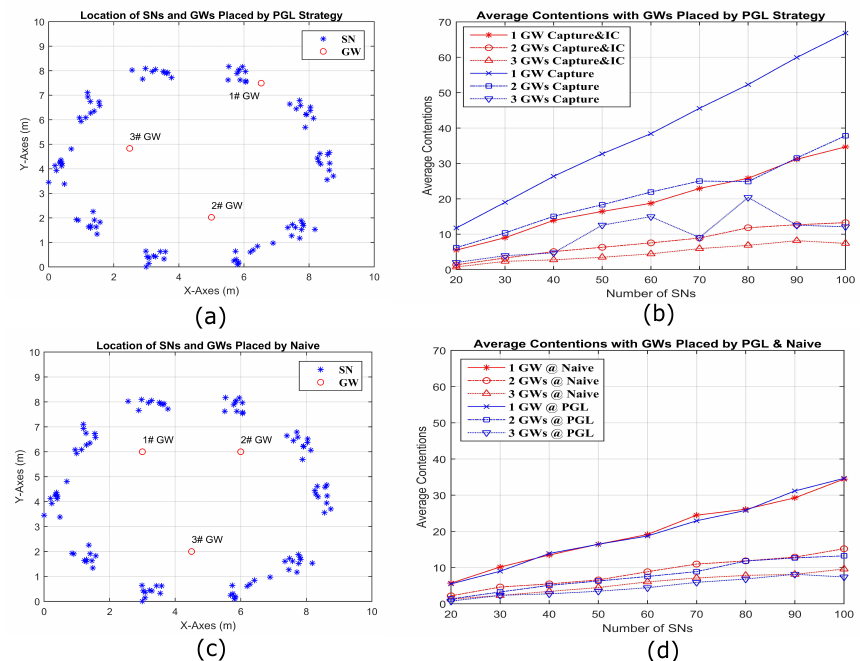
Figure 13. Simulation visualizations for three GWs placed by PGL ( a ) and by naive placement ( c ) in the circumference of a circle composed by 100 SNs. ( b ) The average contentions comparing in different number of GWs by capture and IC to capture only separately; and ( d ) the average contentions comparing for capture and IC in different number of GWs placed by PGL and naive.